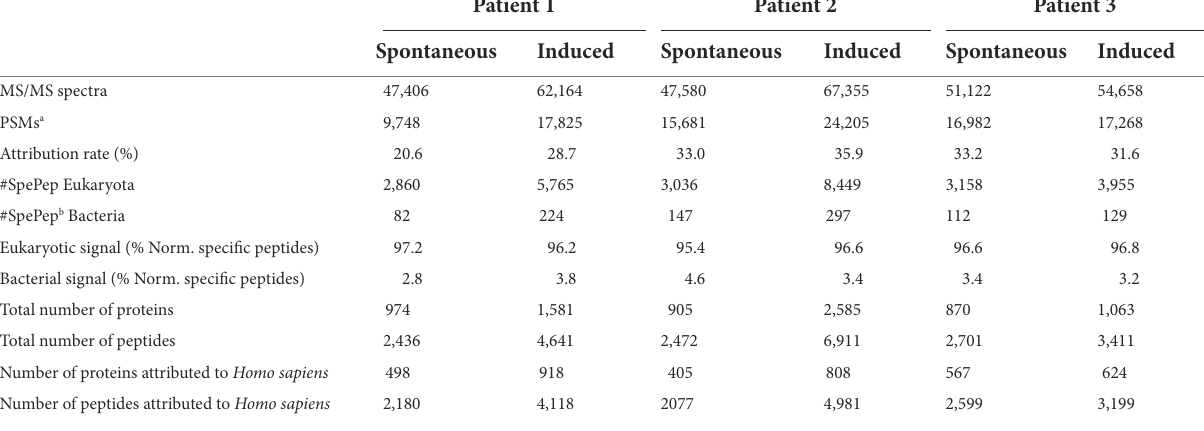
TABLE 3 MS/MS interpretation for spontaneous and induced sputum